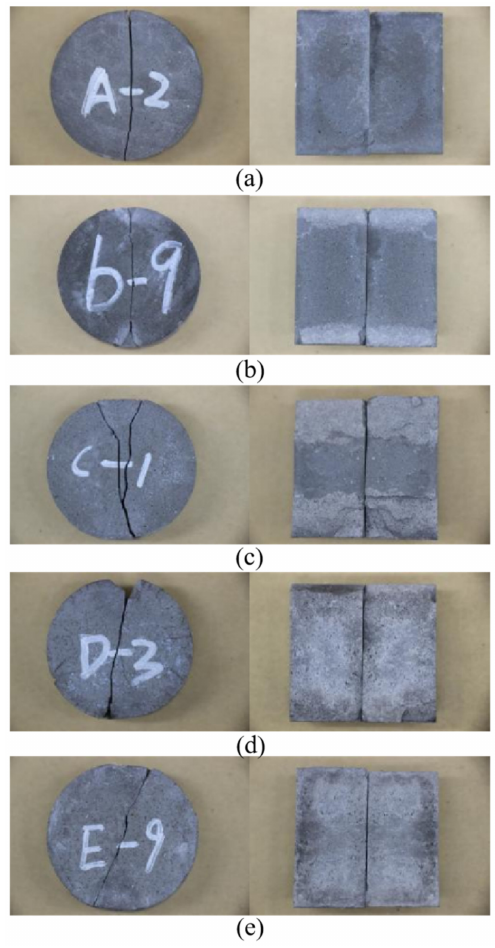
Figure 8. Splitting fracture surface under different temperatures and pressures: ( a ) 25 ◦ C—0 MPa, ( b ) 50 ◦ C—10 MPa, ( c ) 80 ◦ C—20 MPa, ( d ) 110 ◦ C—30 MPa, and ( e ) 140 ◦ C—40